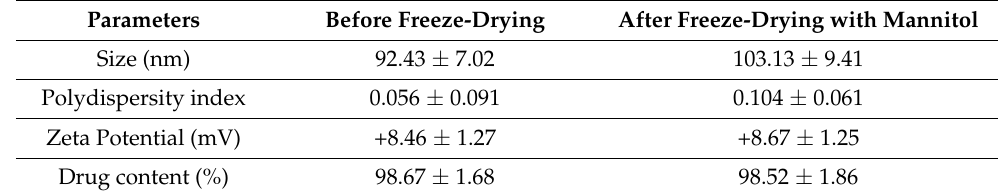
Table 2. Changes in the characteristics of OLA-NCs-2 after freeze-drying. Data are represented as mean of three measurements with standard deviation (Mean ± SD, n =